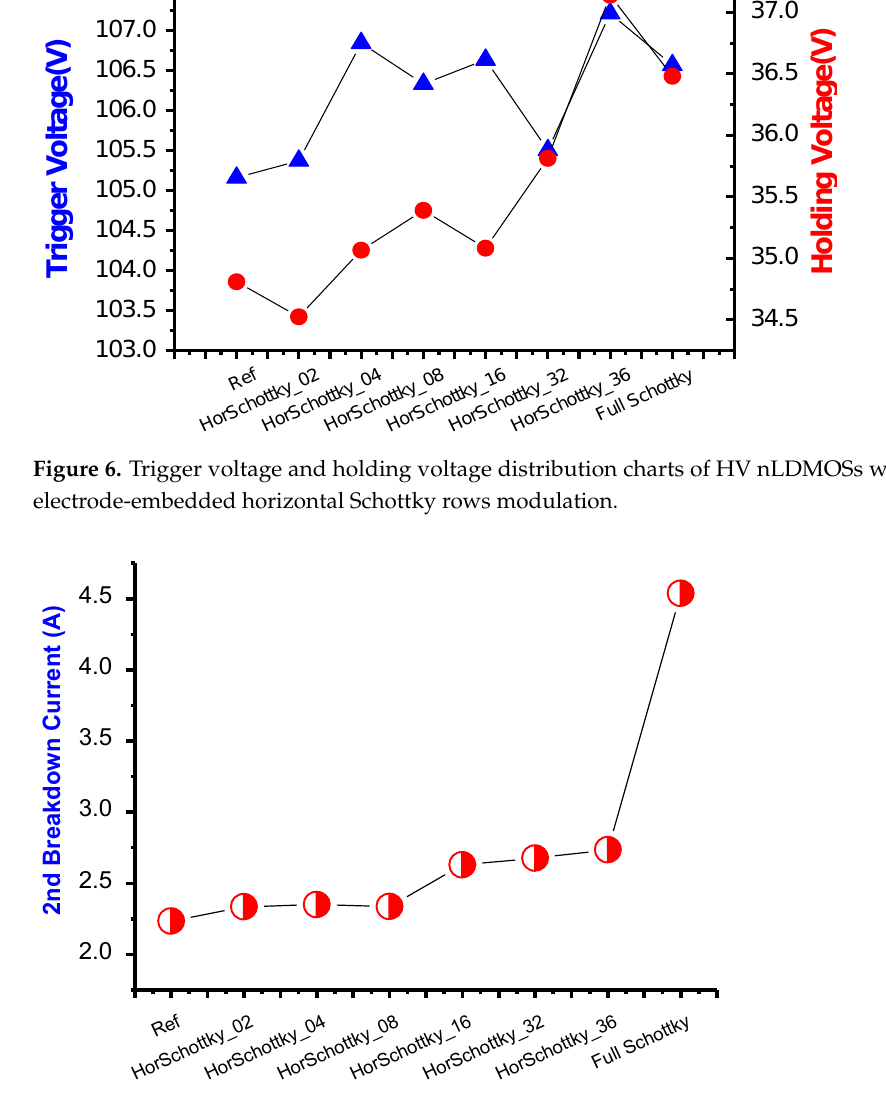
Figure 7. Secondary breakdown-current distribution chart of HV nLDMOSs with the drain elec- trode-embedded horizontal Schottky rows modulation. Table 3. Snapback extracted parameters of HV nLDMOSs with the drain electrode-embedded horizontal Schottky rows modulation.